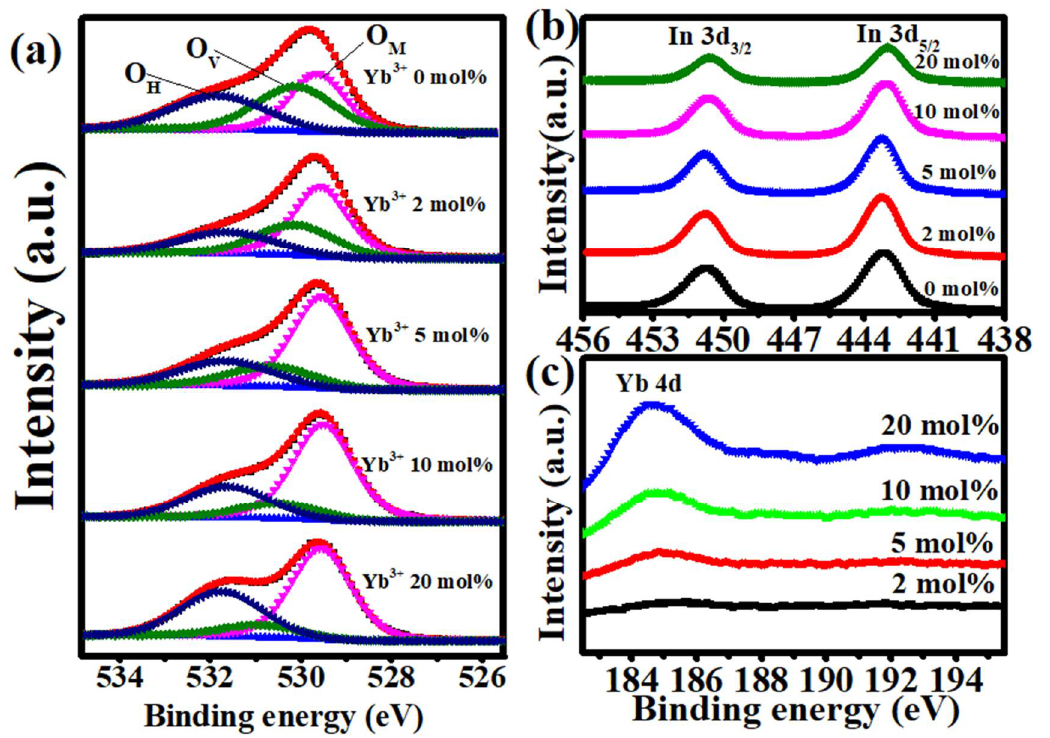
Figure 5. XPS spectra of: ( a ) O 1s, ( b ) In 3d, and ( c ) Yb 4d for In-Yb-O with different Yb ratios.